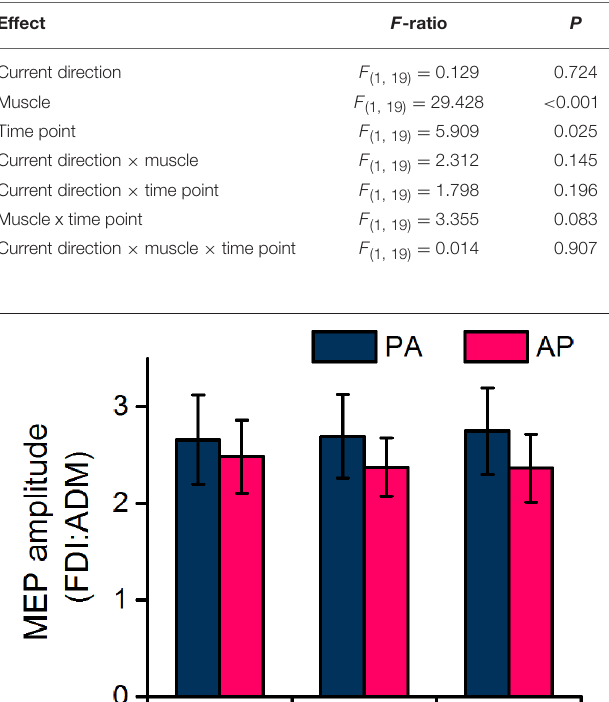
FIGURE 3 | Motor evoked potential amplitudes recorded from the FDI and ADM muscles during the extra-task baseline (B ET ) and the action observation task (intra-task baseline, B IT ; precision grip, PG). Dashed line separates measurements made outside of the observation task (B ET ) from those within the task (B IT , PG). Data are shown in absolute terms (A) and normalized to extra-task baseline (B) or intra-task baseline (C) .